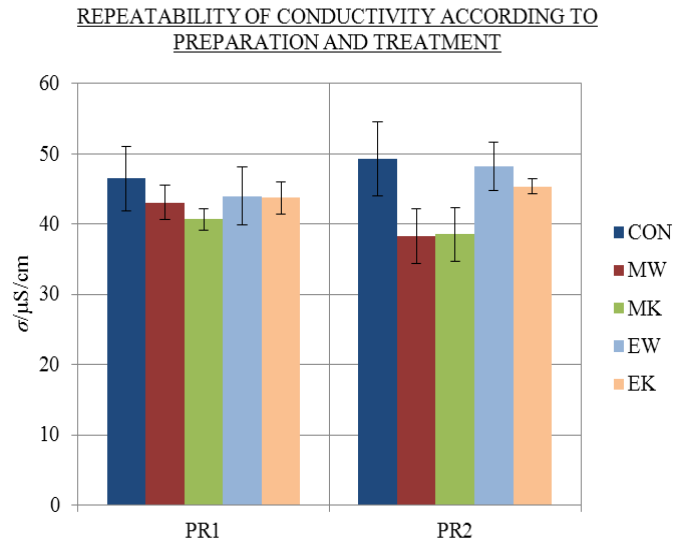
Figure 2. Repeatability of average σ with standard error (SE) intervals at 25 °C and 1000 Hz after 310 days of ageing of 2 mL treatments CON (blue), MW (red), MK (green), EW (light blue) and EK (orange) of preparations PR1 and PR2; number of replicates, N (/), of PR1: CON (5), MW (7), MK (7), EW (5), EK (5); number of replicates of PR2: